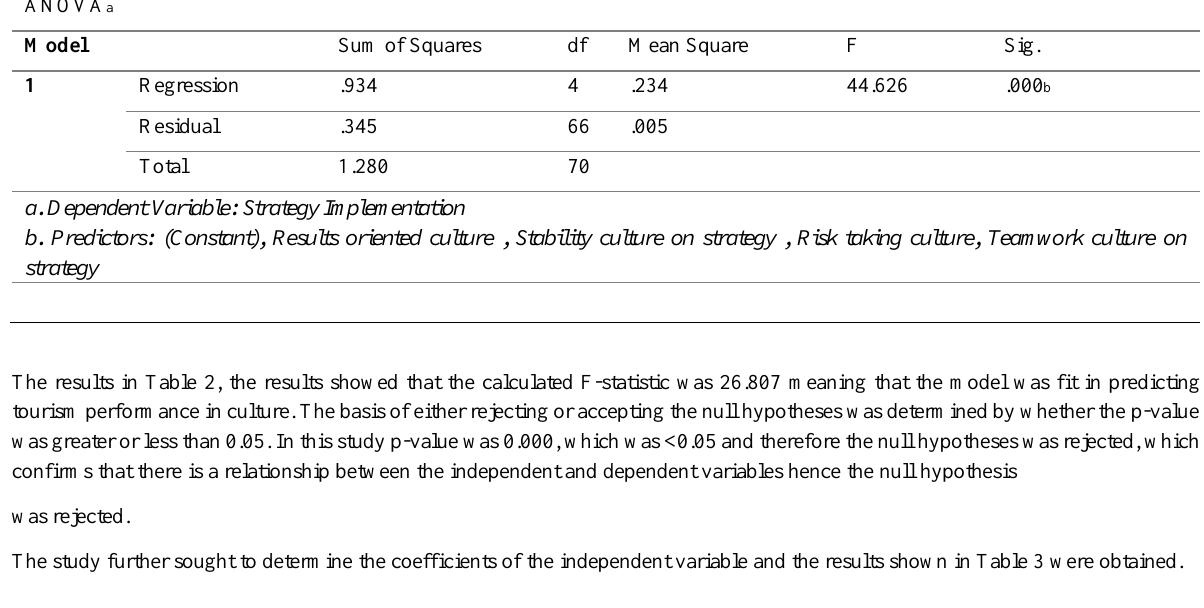
Table 3: Coefficients Relationship between Culture and Strategy